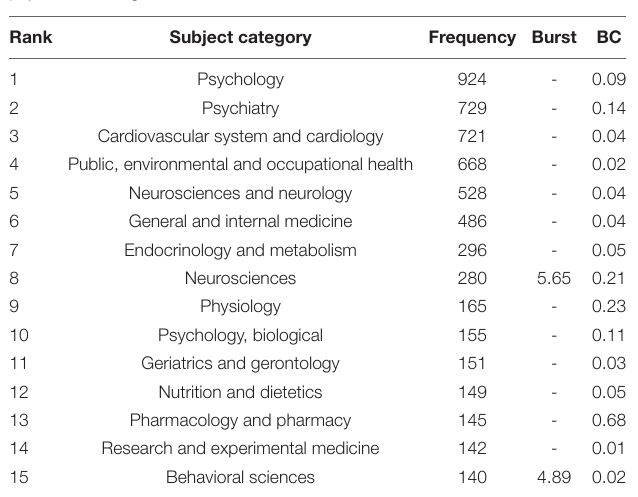
TABLE 3 | Top 15 subject categories of publications about the psycho-cardiological disease and related literature.